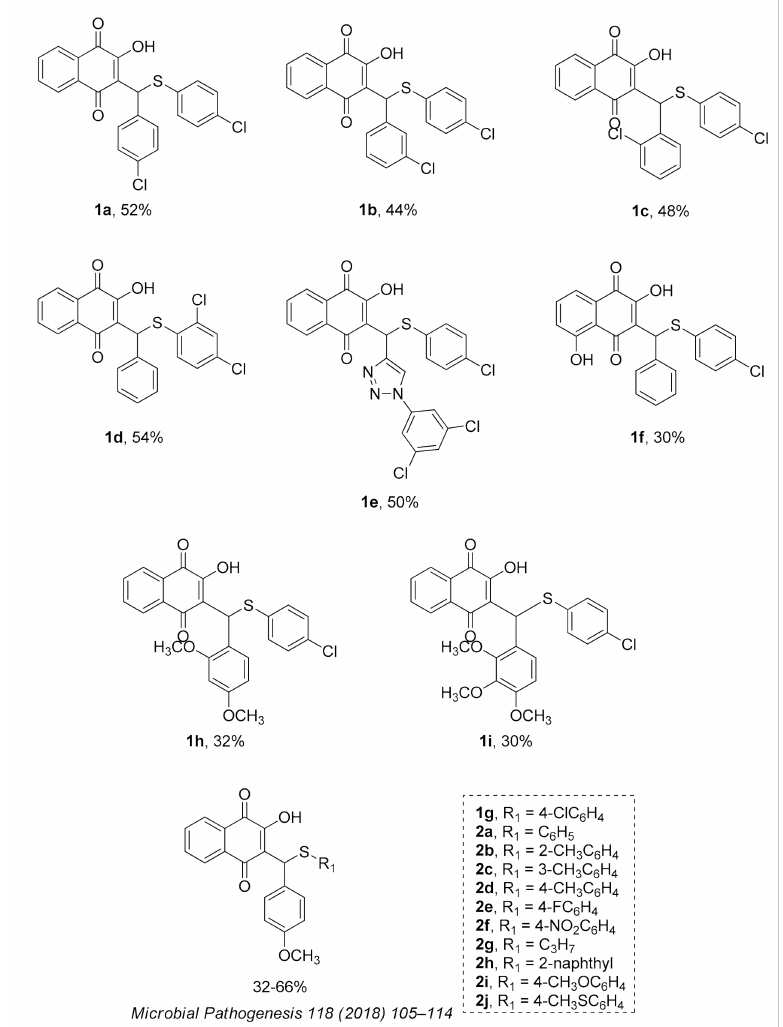
Figure 4. Structure and yields of 2-hydroxy-3-phenylsulfanylmethyl-[1-4]-naphthoquinone derivates. dione ( 1b